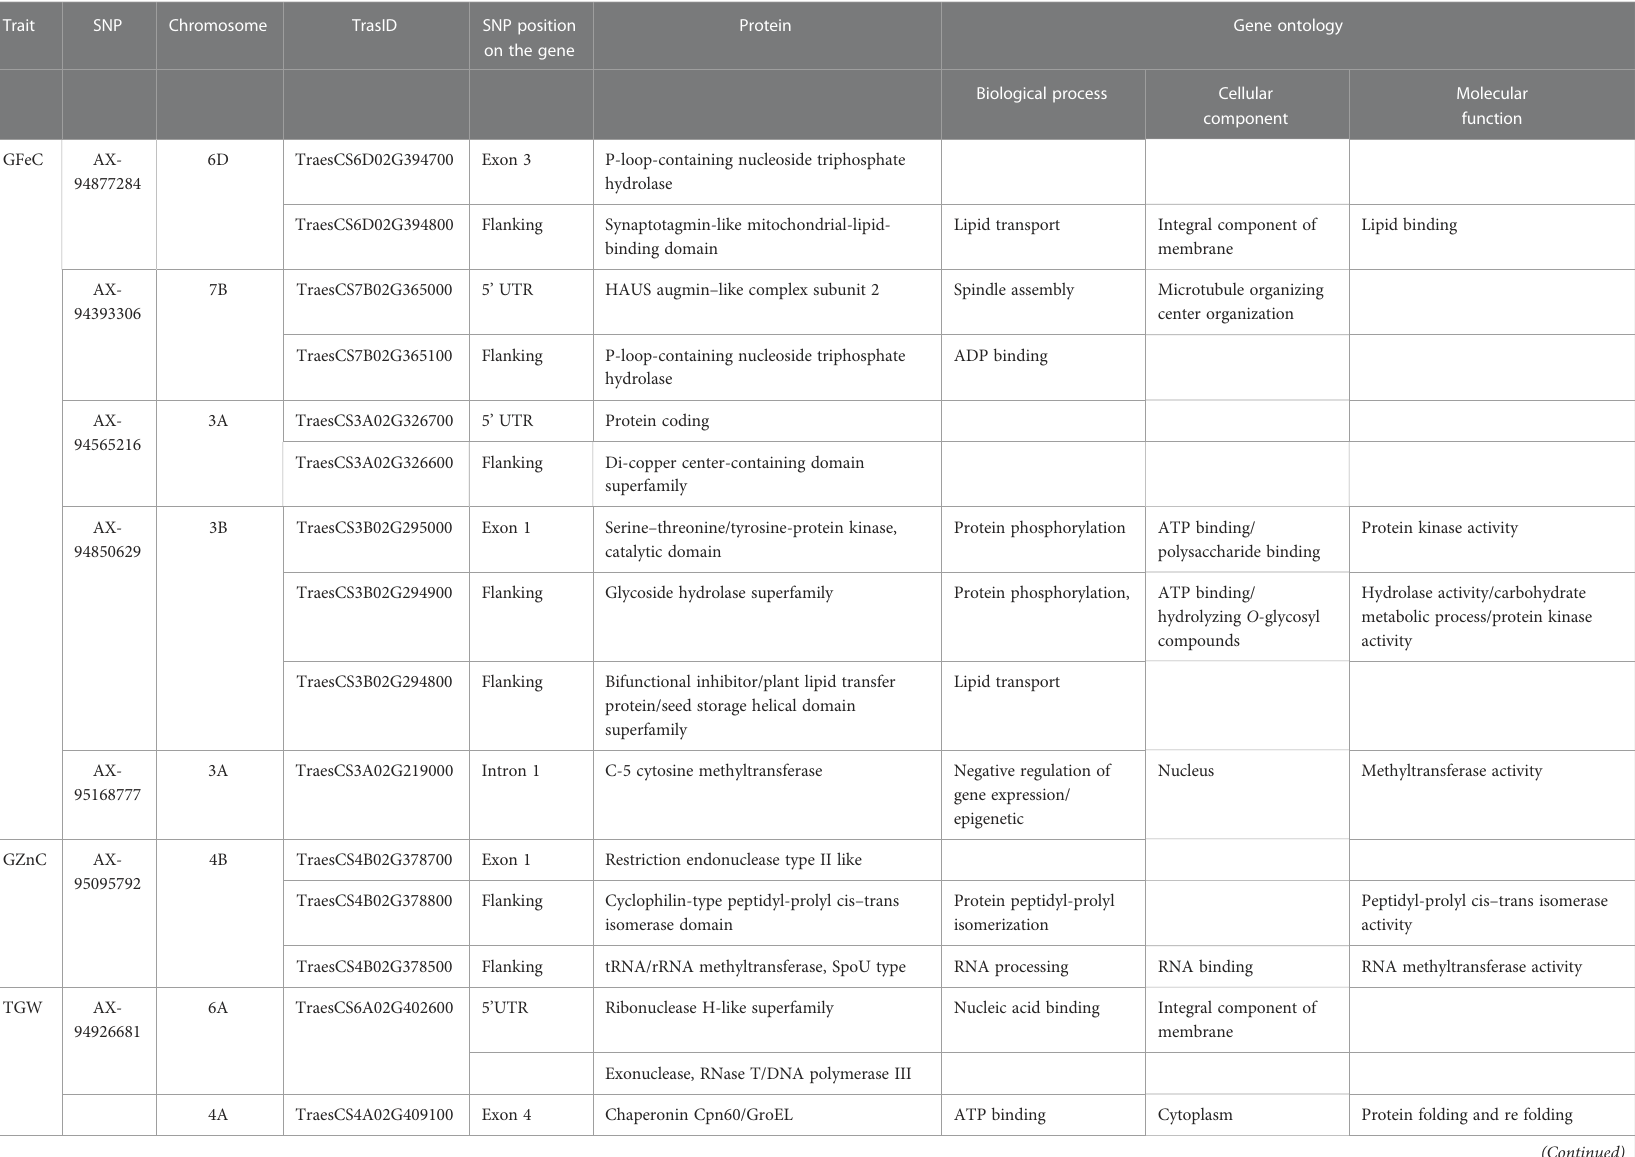
TABLE 5 Putative candidate genes in the 100-kb region of the linked marker with protein produced and gene ontology studies.